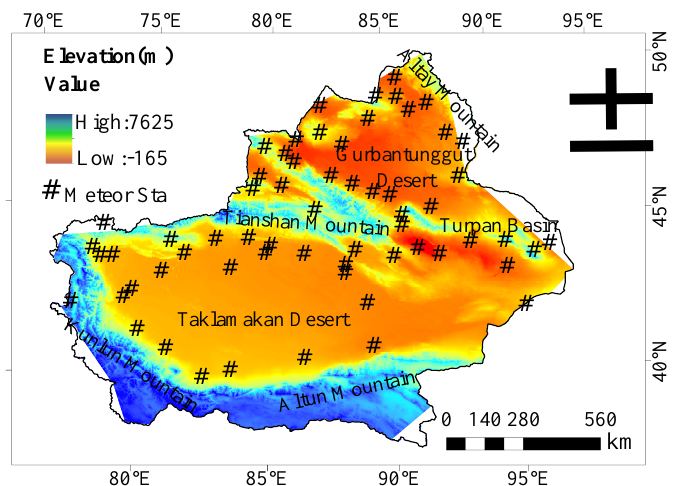
Figure 1. Location of the study area and distribution of the meteorological stations.